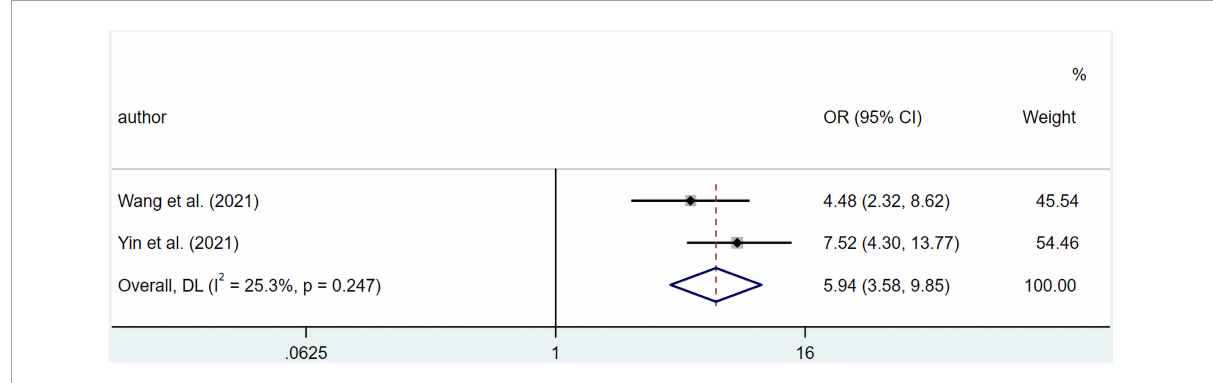
FIGURE5 Forest plots showing pooled HR with 95% CI of overall complications under multivariate regression model. X-axis indicated odds ratio (OR). Weights are from random-effects model.